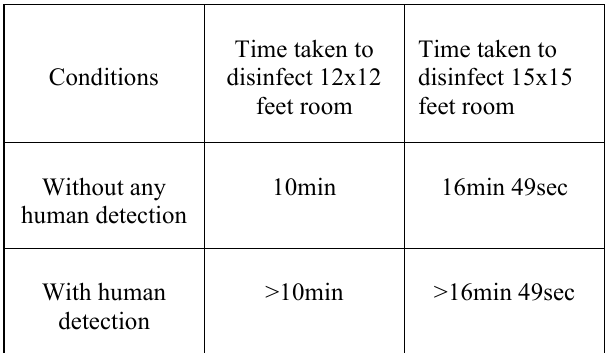
Table 1. Disinfection time in rooms of different